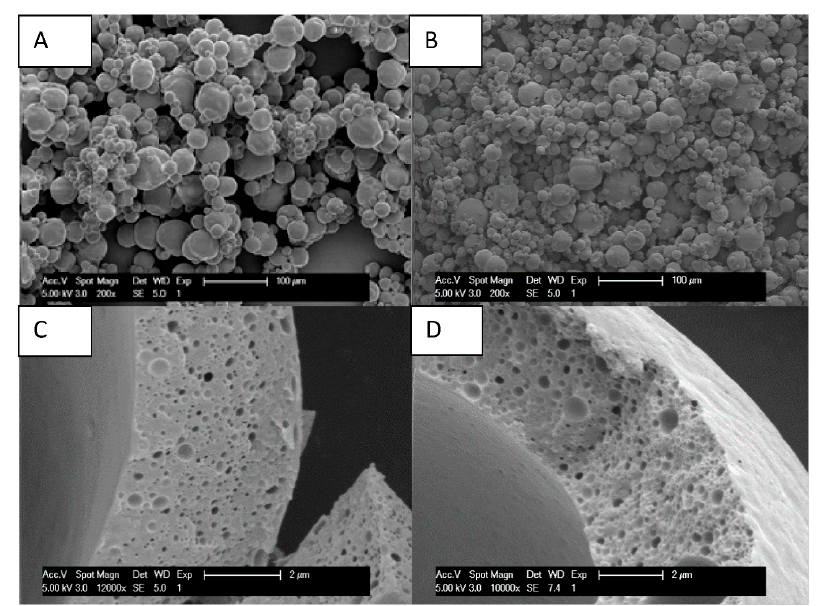
Figure 2. The typical outer topography ( A , B ) and inner structure ( C , D ) of the investigated spray-dried microcapsules. Microcapsules in ( A – D ) were prepared with CIWE 2.5/17.5/25:75, 5.0/15.0/50:50;2.5/17.5/25:75, and 5.0/15.0/50:50, respectively.